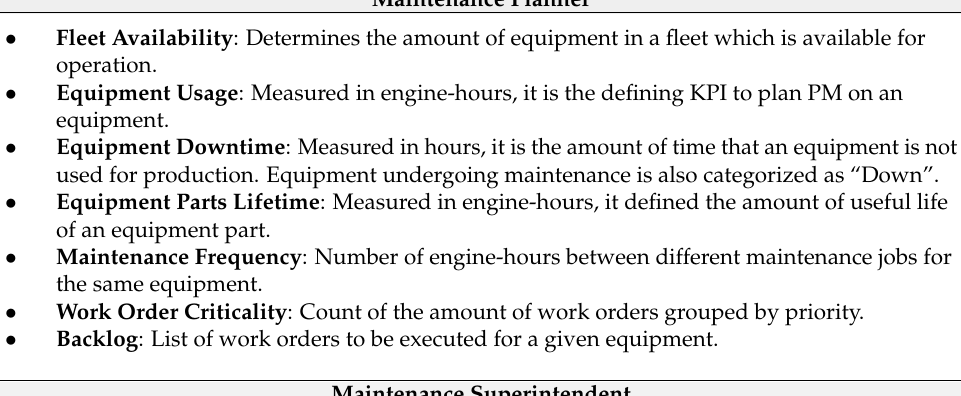
Table 4. KPIs by participant’s role.